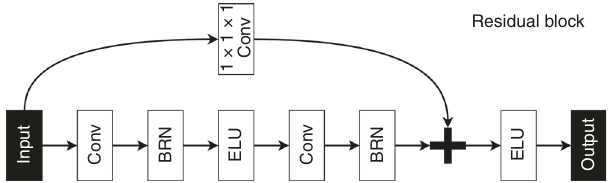
Fig. 4 A fl owchart showing the components of the proposed residual block. Batch re-normalization (BRN), convolutional layer